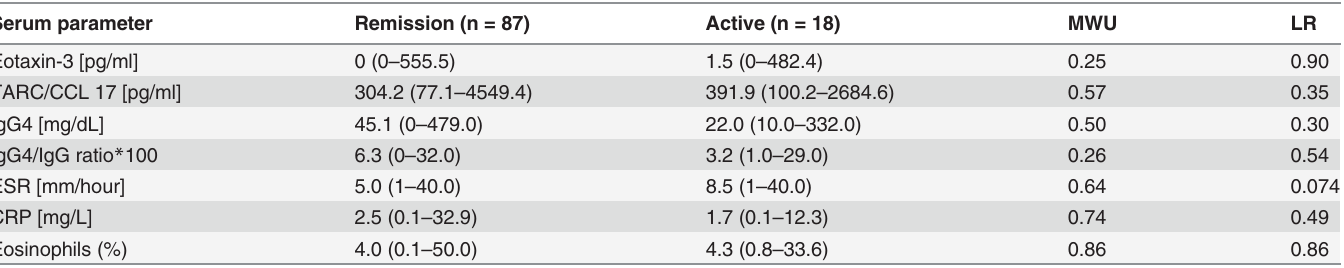
Table 2. Serum biomarkers of patients with EGPA in remission and at relapse. Serum